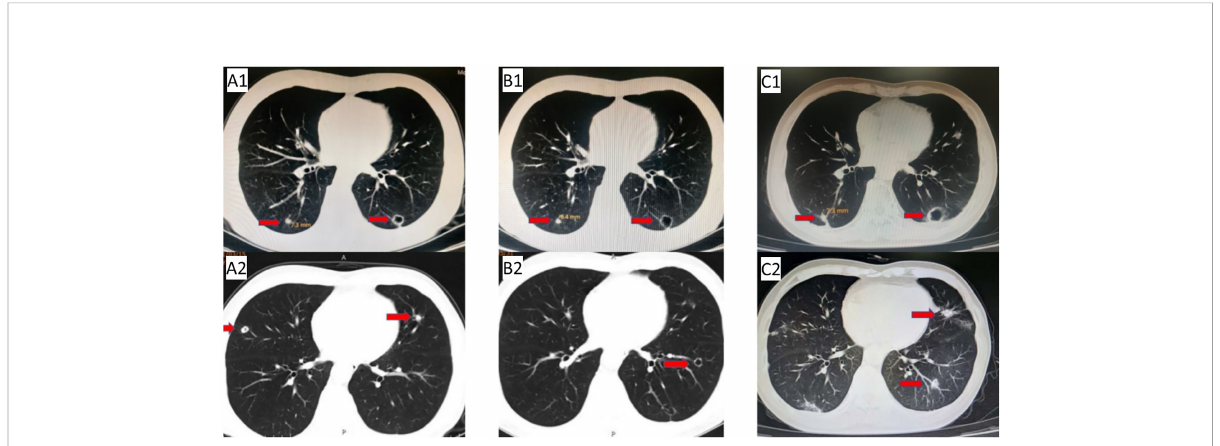
FIGURE 3 Anlotinib + TAS-102 treatment: (A1/A2) CT after 2 cycles (2021.03.15): the pulmonary nodules were larger than before (the right pulmonary nodules was 7.3 mm), and some cavities were formed; (B1/B2) reexamination CT (2021.05.31) showed that the right pulmonary nodules were smaller than before (6.4 mm); (C1/C2) last reexamination CT (2022.08.23): the right pulmonary nodules was 7.3 mm; multiple nodules in the left lung, and some cavities were formed.